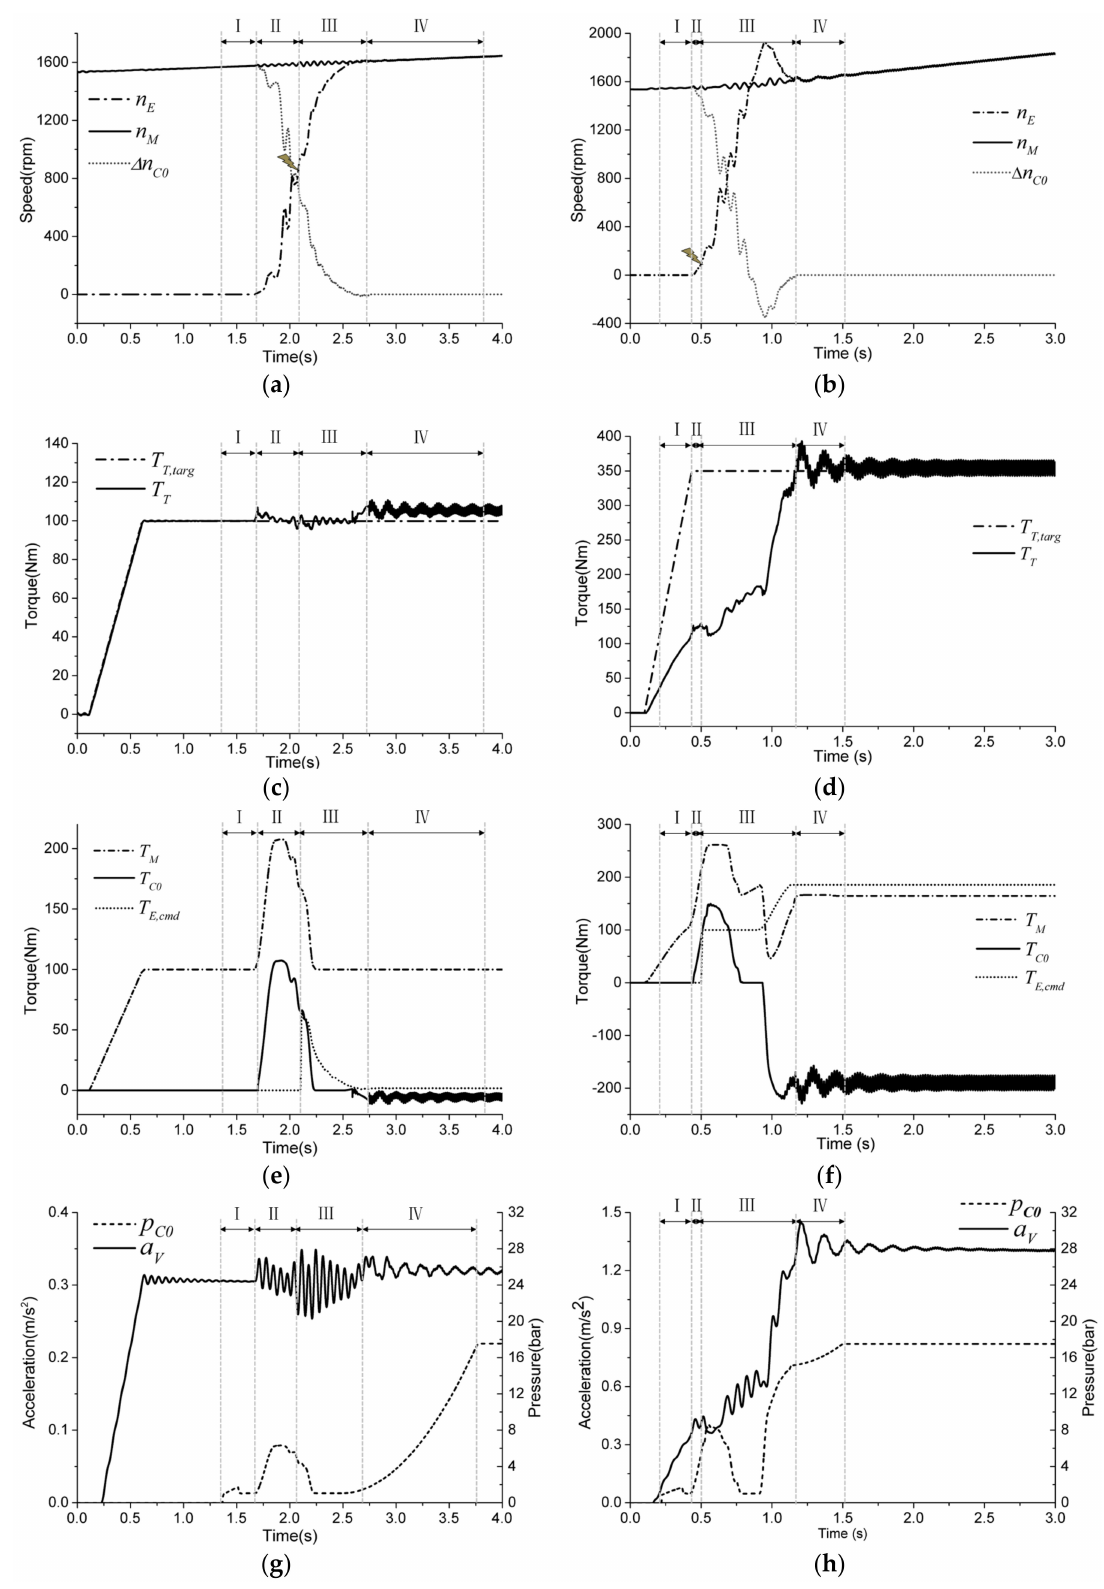
Figure 14. Comparative simulation results of two transitions in the common coasting driving condition: soft start: ( a , c , e , g ); dynamical start: ( b , d , f , h